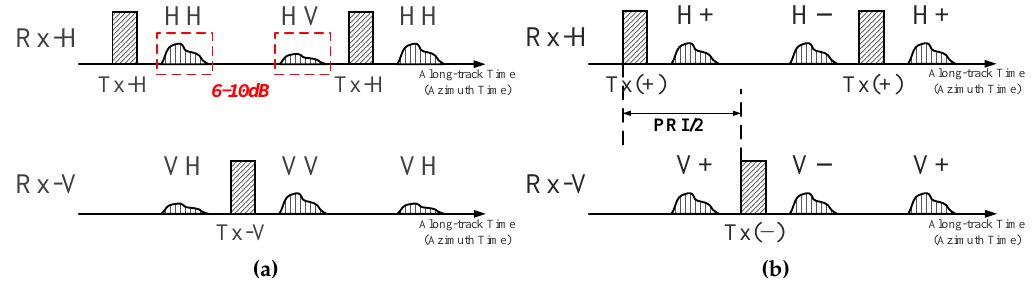
Figure 1. Timing diagram for transmitted signal and received echo. ( a ) Conventional quad-pol SAR system. ( b ) Hybrid quad-pol SAR system.Tx/Rx indicates the transmission/reception of the signals; the tags of HH/HV/VH/VV and H + /H − /V + /V − indicate the received echoes. PRI is pulse repetition interval and is the reciprocal of pulse repetition frequency